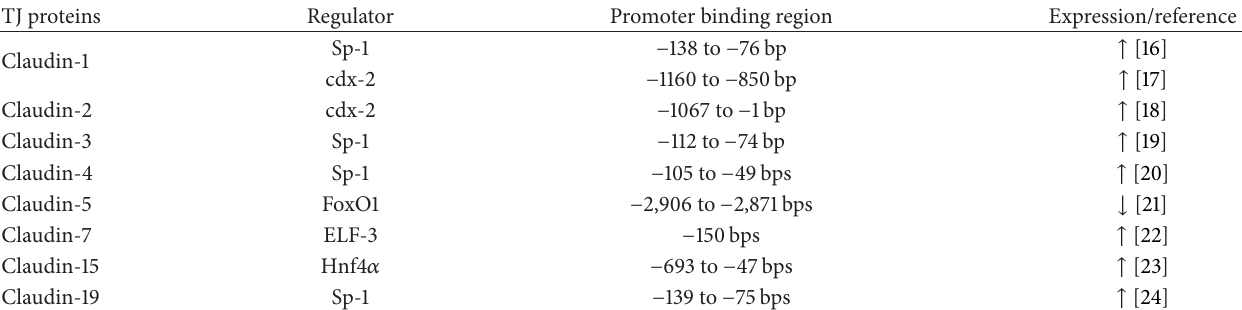
Table 1: Regulators of